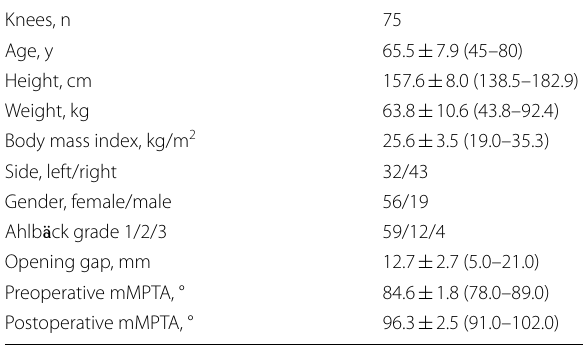
Table 1 Patients’ demographic